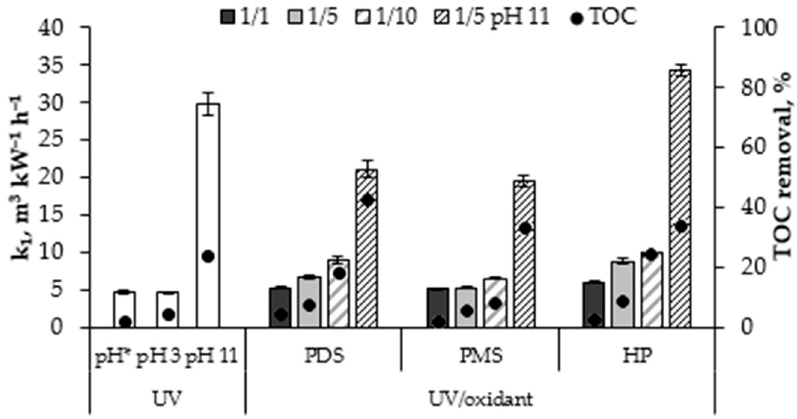
Figure 3. Effects of pH and VMN/oxidant molar ratio on the target compound UV photolytic oxidation rate constant k 1 and TOC removal ([VMN] 0 = 13.5 µ M, unadjusted pH*, treatment time for TOC removal 2